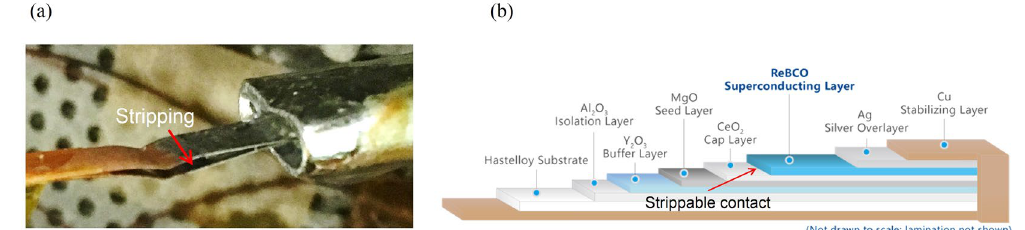
Figure 4. ( a ) Stripping happens to the YB 2 C 3 O 7- δ wire terminal immersed in SN 2 in Ling’s experiemnt 30 due to different thermal contractions. ( b ) A typical structure of an HTS wire 40 . The stripping usually happens between ReBCO (Re = rare earth) layer and CeO 2 layer, which are mechanically vulnerable.